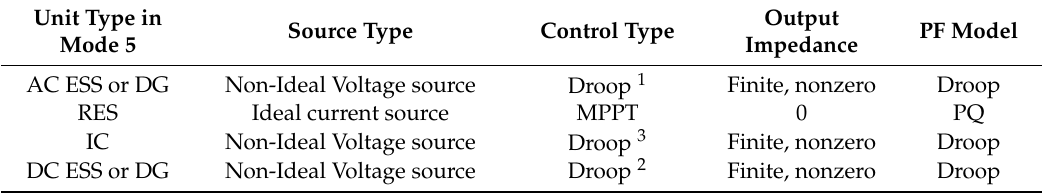
Table 3. Electrical behavior of the main components of IHMG in mode